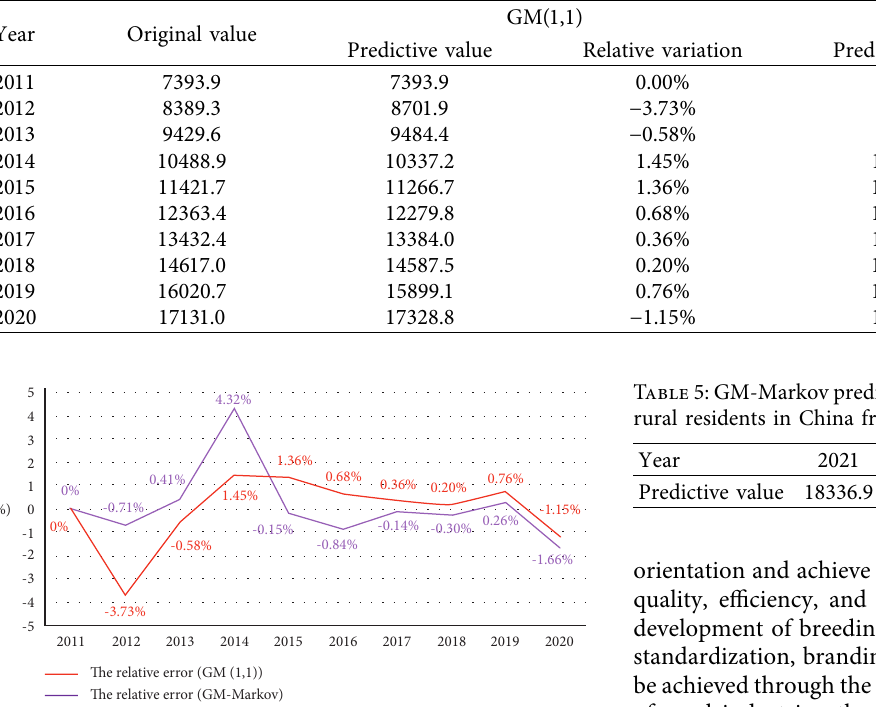
Figure 5: Relative error comparison between GM (1,1) model and GM-Markov model.